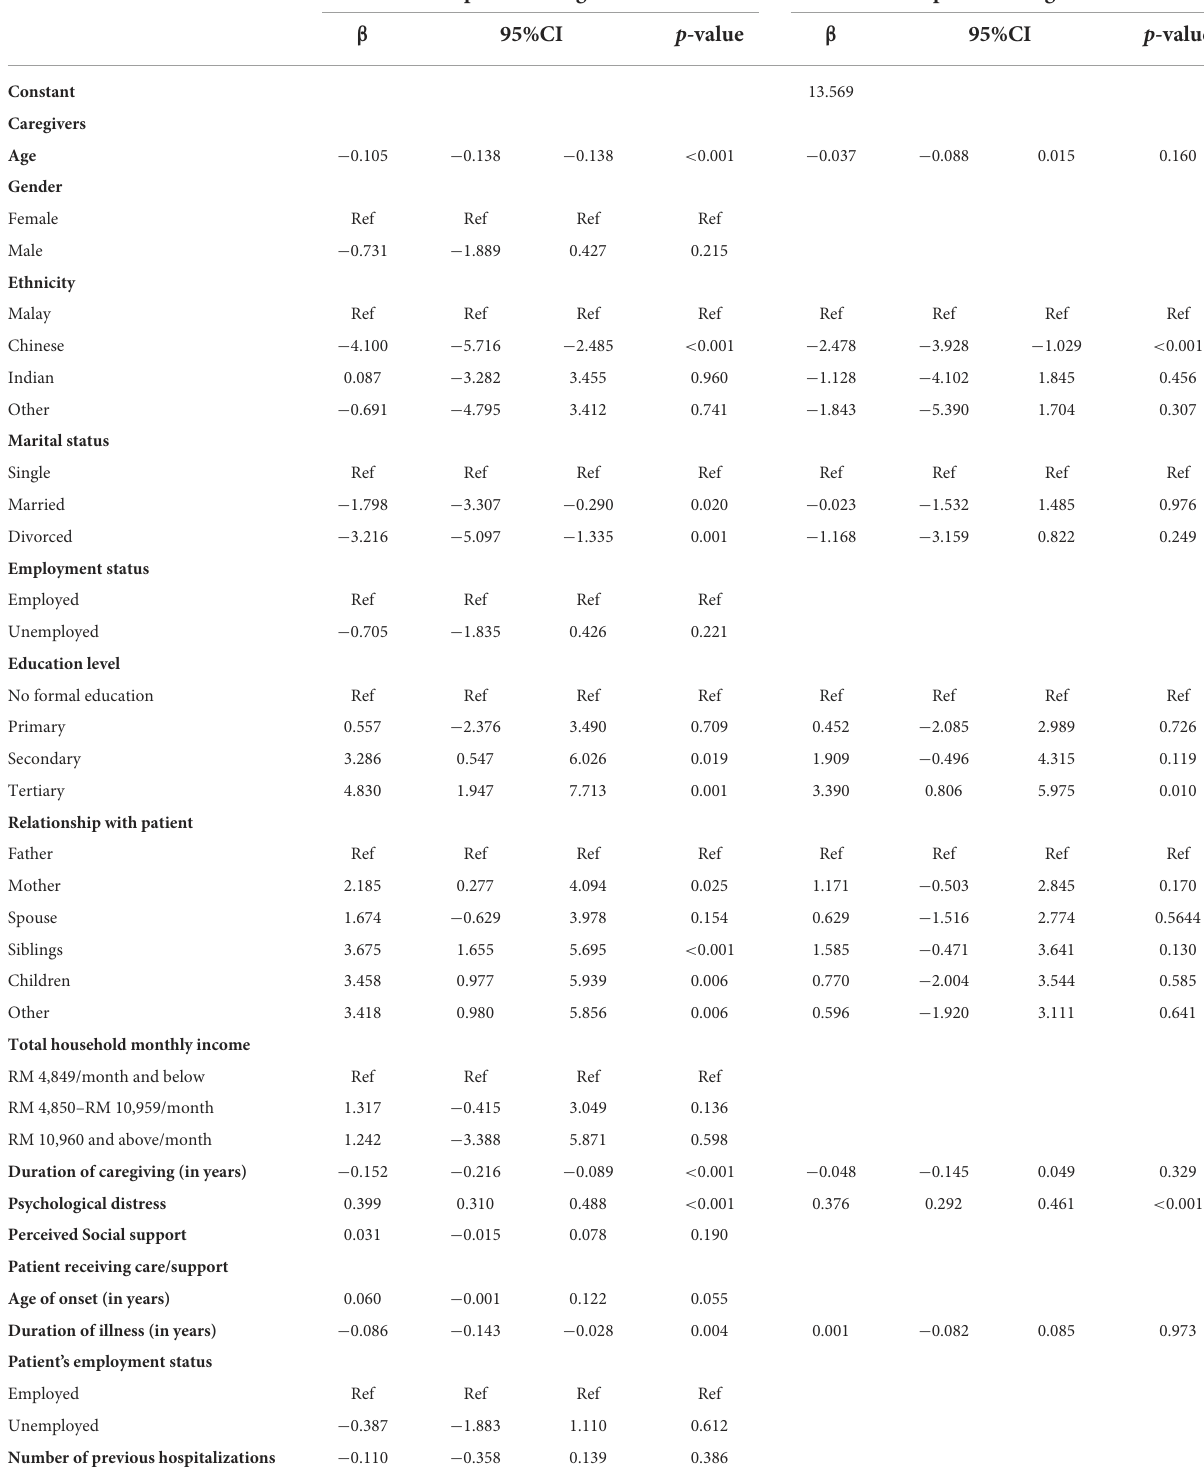
TABLE 6 Factors associated with avoidance coping strategies among caregivers of patients with schizophrenia. Factors Simple linear regression Multiple linear